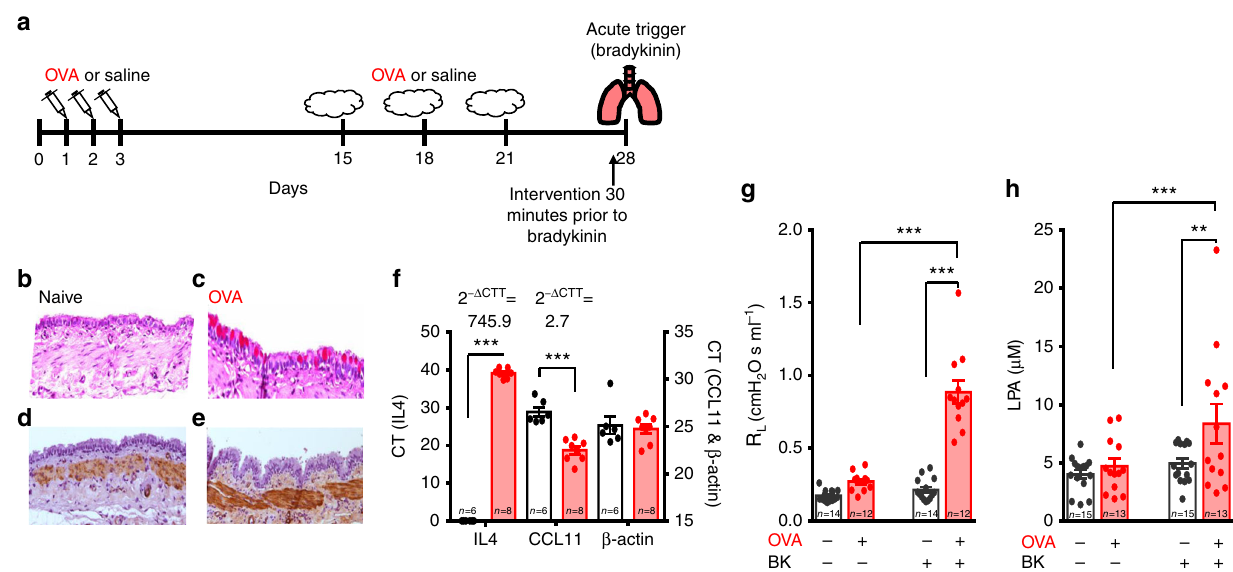
Fig. 4 Ovalbumin-sensitized rats demonstrate increased airway remodeling, in fl ammatory markers, airway resistance and plasma LPA. a OVA-sensitization protocol (see Methods, OVA Cohort 1). b – e Typical asthmatic airway disease occurred in the OVA-sensitized rats (right c , e ) compared to the naive group (left b , d ) as indicated by the heightened presence of goblet cells (appearing pink with Periodic acid-Schiffs reagent; b , c ) and thickening of airway smooth muscle (appearing brown when immuno-stained for smooth muscle actin; d , e ). f qPCR of IL4, eotaxin (CCL11) and house-keeping gene β -actin for OVA (red) and naive (open) rats with calculated change in gene expression magnitude (2 − Δ CTT68 ). CT: cycles threshold. OVA vs naive CT for IL4-independent t- test, t = 73.271, *** p < 0.00001; CCL11-independent t -test: t = 6.369, *** p < 0.0001; and β -actin-independent t -test: t = 0.403, p = 0.694. g 11 12 12 Bradykinin increases R L in OVA animals only (red; F 1,51 (two-way RM ANOVA) = 69.224, p < 0.001). Holm – Š idák post hoc: bradykinin increases R L in OVA animals, *** p < 0.001; but not naive rats ( p = 0.40). Prior to bradykinin R L in naive (open) and OVA rats is not signi fi cantly different ( p = 0.08),